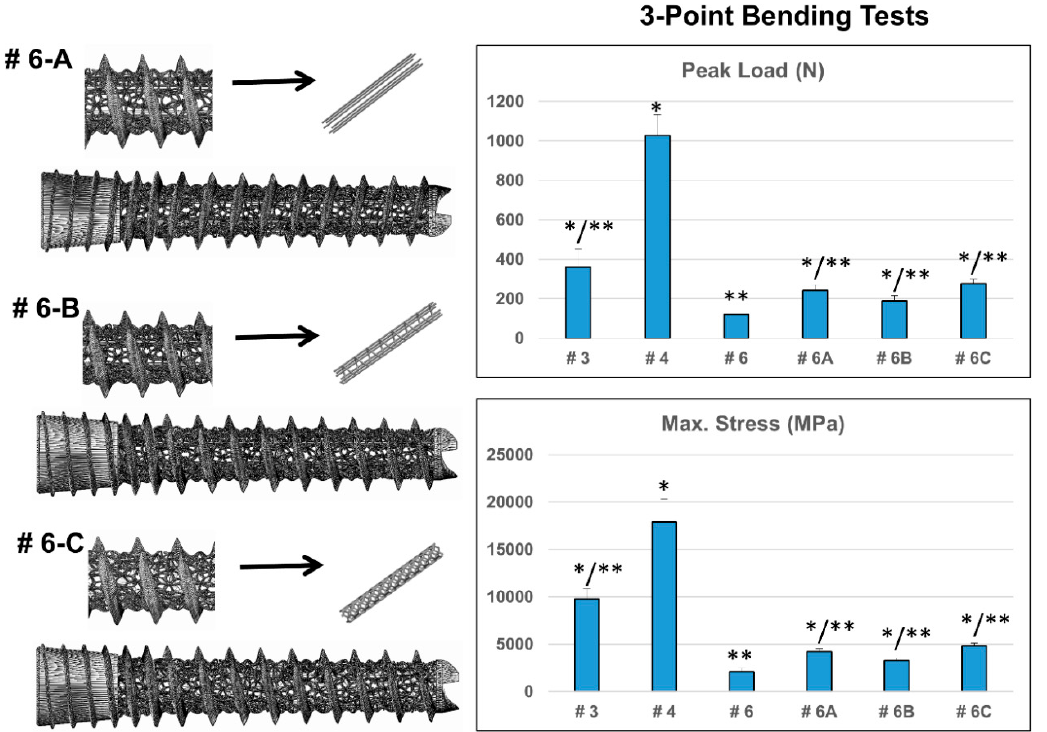
Figure 3. Morphological characteristics and biomechanical parameters of the augmented biomimetic DMLS Ti 6 Al 4 V dental implants (n = 10 for each design). The weaker type #6 dental implant (300–500 µ